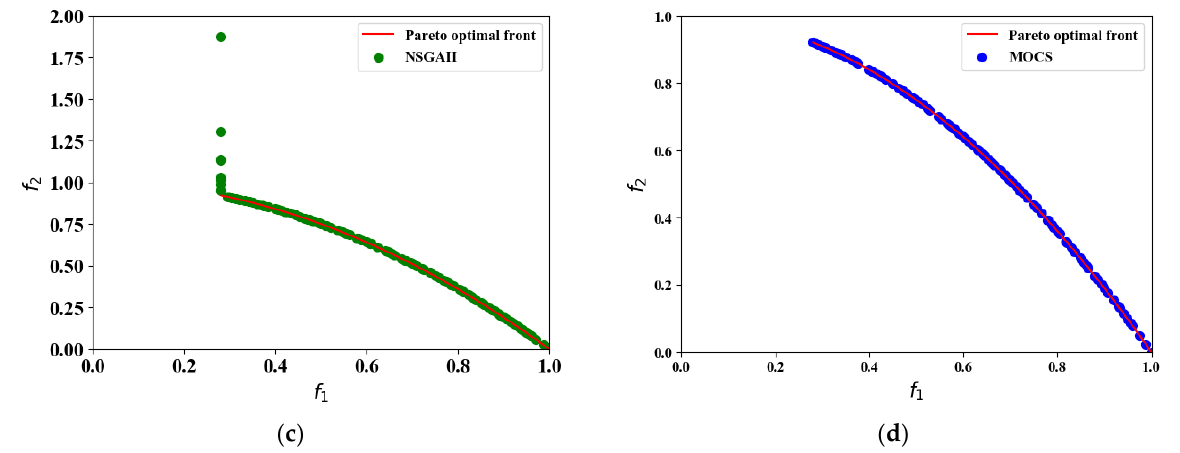
Figure 6. The convergence results of ZDT6 test problem over all algorithms. ( a ) IMOCS, ( b ) SPEAII, ( c ) NSGAII, and ( d ) MOCS.